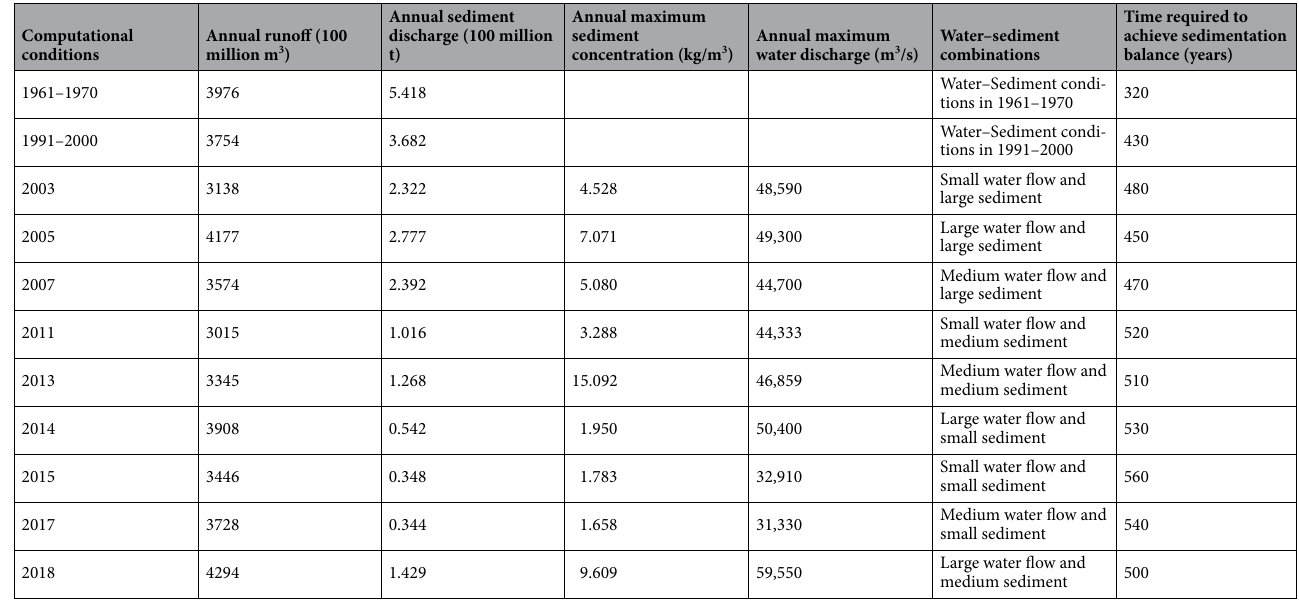
Table 9. Time required by the different computational schemes to achieve sedimentation